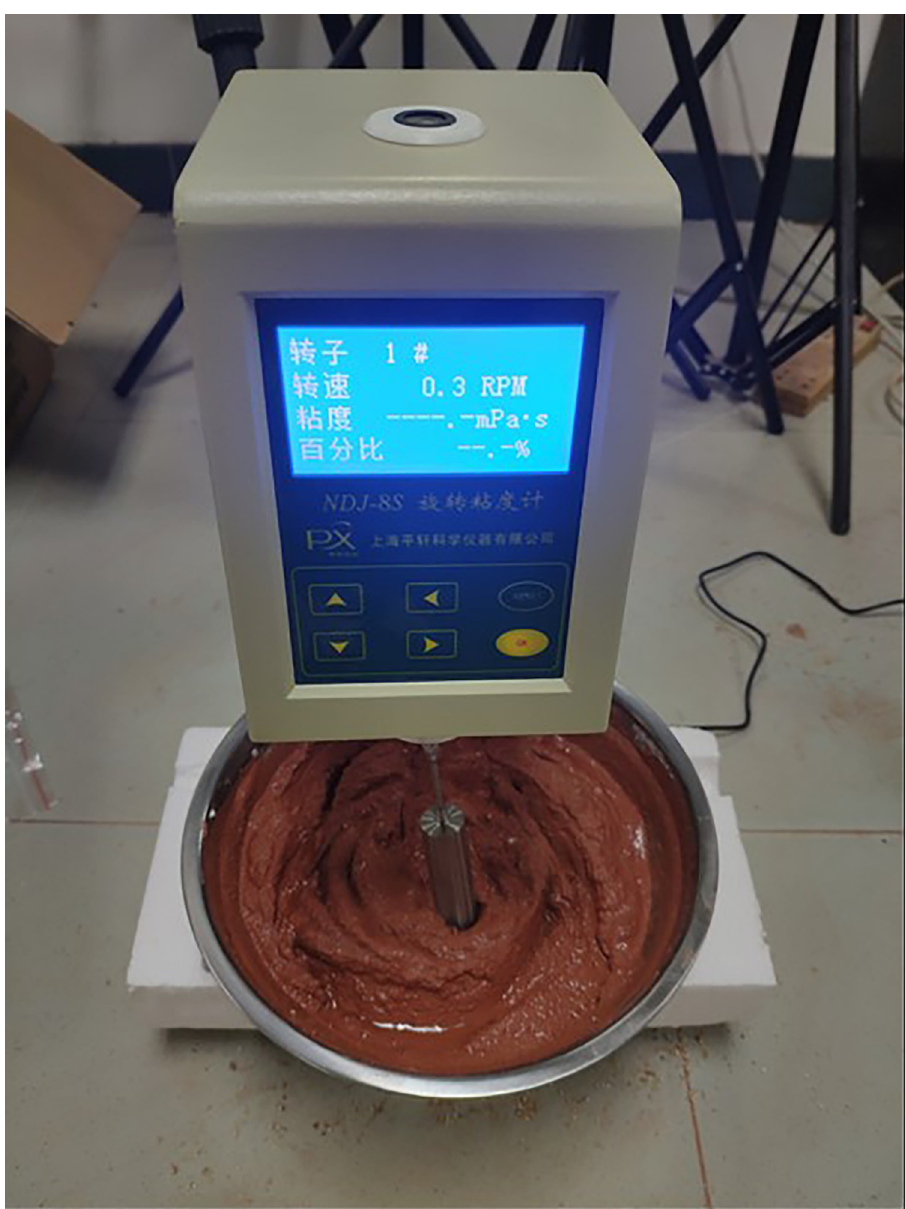
Fig 5. Viscosity measurement of the naturally weathered red-bed soil